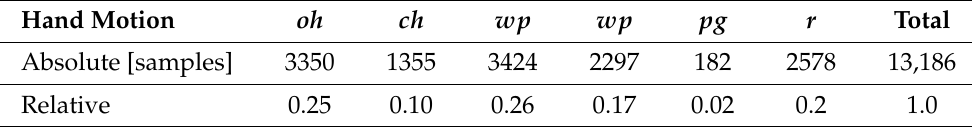
Table 6. Absolute and relative amount of adapted data points per hand motion for all subjects. Hand